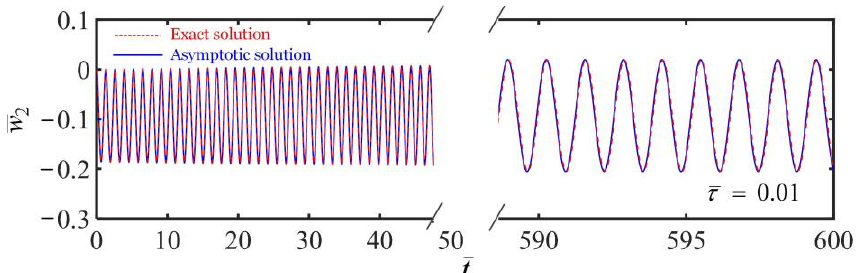
Figure 6. Variation of the displacement of the mass block with time during the self-sustained oscillation in a linear temperature field with a static frame. The LCE fiber in the linear temperature field can stretch or shorten continuously and eventually develop into a periodic self-sustained oscillation.